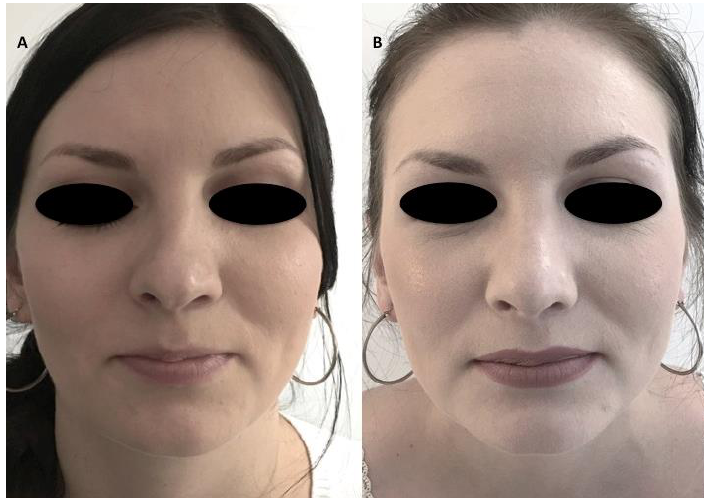
Figure 5. 43-year-old female patient affected by nasal obstruction and minor soft tissue defects in frontal view. ( A ) External nose analysis showed external nasal valve collapse, deficit of supra tip projection, deficit of radix and dorsum volume. Anterior rhinoscopy showed a deviated nasal septum and bilateral stenosis of the internal valves. ( B ) The fluid cartilage as filler was injected on the external nasal valve collapse, in the alar cartilage side, or in the radix, or in the nasal dorsum or in the supra tip area. Post-operative follow-up evaluation, 12 months after the fluid cartilage injection showed optimal aesthetic results and an improvement of nasal obstruction.